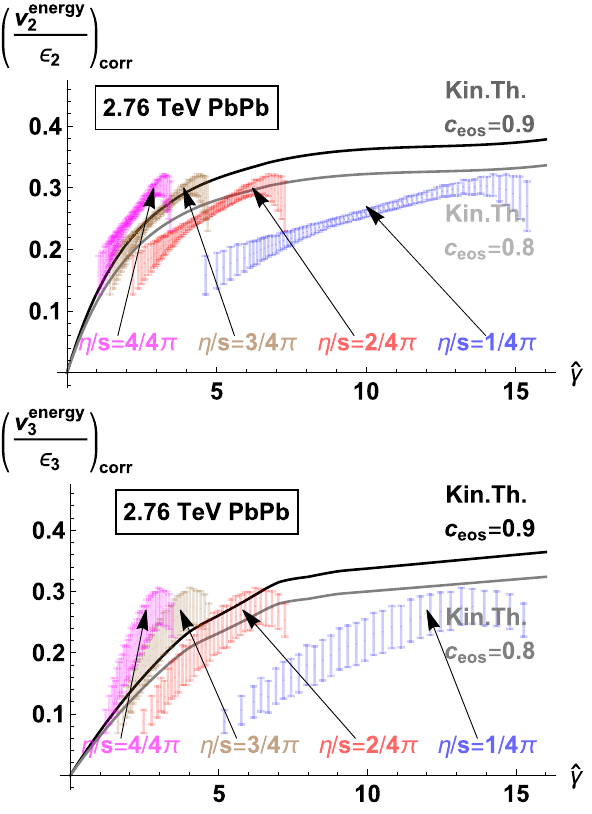
Fig. 12 Selected data from Figs. 10 and 11 with an indication of the centrality range corresponding to different values of ˆ γ